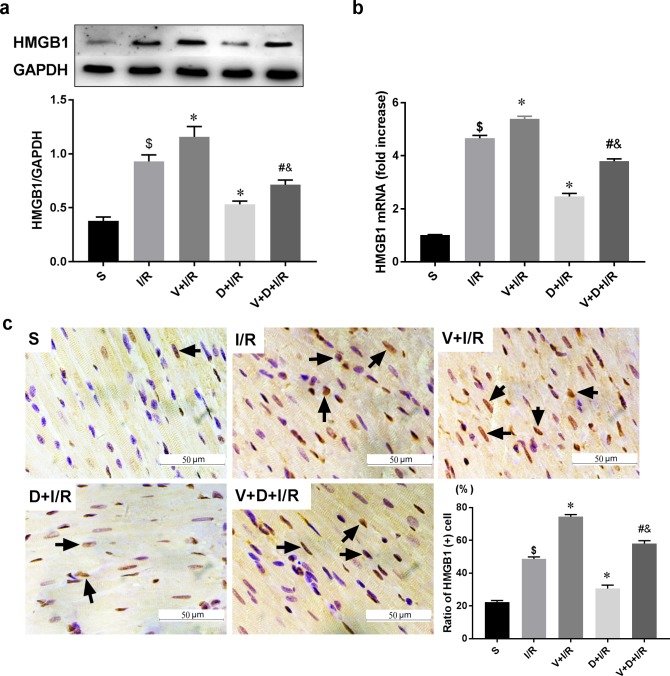
The vagal nerve modulates DEX-induced downregulation of cardiac HMGB1 during I/R.Unilateral vagotomy or sham operation was induced before DEX or saline pretreatment followed by myocardial I/R. HMGB1 protein levels in the left ventricles were measured using Western blot (a) and HMGB1 mRNA levels were assessed by qRT-PCR (b). Representative images of immunohistochemical staining for HMGB1 and quantitative results (c). Arrows indicate HMGB1-positive cells. Scale bar = 50μm. All specimen were obtained at the timepoint of myocardial I/R for 2hrs. Data shown are mean ± SEM; n = 6 per group; $ p<0.05 vs. S; *p < 0.05 vs. I/R; #p < 0.05 vs. D+I/R; &p < 0.05 vs. V+I/R. S: sham operation; I/R: myocardial ischemia-reperfusion; D: dexmedetomidine; V: vagotomy;